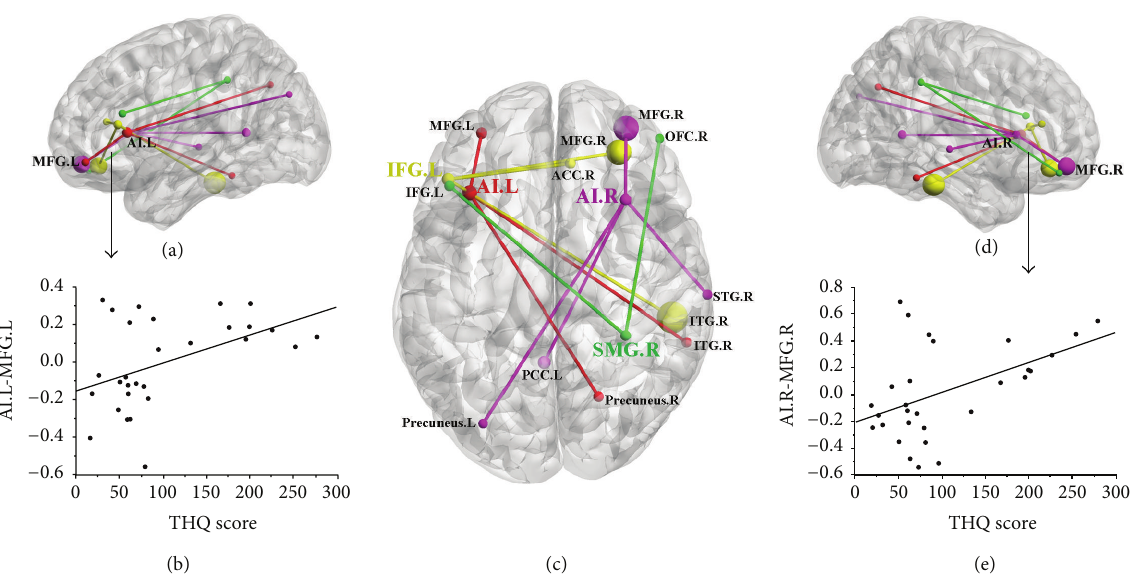
Figure 2: Relationships between abnormal functional connectivity and tinnitus distress. ((a)-(b)) The functional connectivity of left AI to left MFG was correlated with the THQ score ( 𝑟 = 0.459 , 𝑃 = 0.012 ). (c) The aberrant brain connectivity networks from four seed regions. The red represents the left AI; the magenta represents the right AI; the yellow represents the left IFG; the green represents the right SMG. ((d)-(e)) The functional connectivity of right AI to right MFG was correlated with the THQ score ( 𝑟 = 0.479 , 𝑃 = 0.009 ). L: left; R: right; THQ: Tinnitus Handicap Questionnaires; AI: anterior insula; IFG: inferior frontal gyrus; SMG: supramarginal gyrus; MFG: middle frontal gyrus; STG: superior temporal gyrus; ITG: inferior temporal gyrus; ACC: anterior cingulate cortex; PCC: posterior cingulate cortex; OFC: orbitofrontal